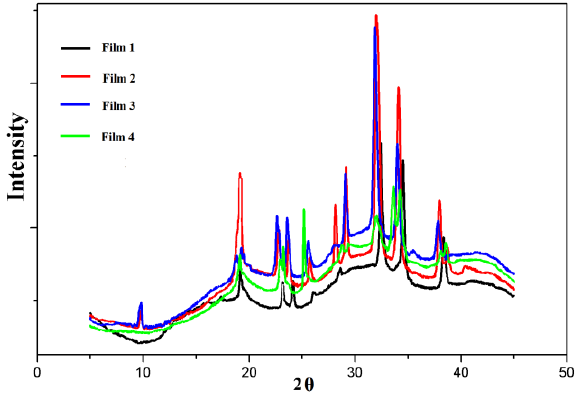
Figure 4. The XRD patterns of Film 1, Film 2, Film 3, and Film 4. Table 2. The degree of crystallinity of QH, CMC, and the blended films.